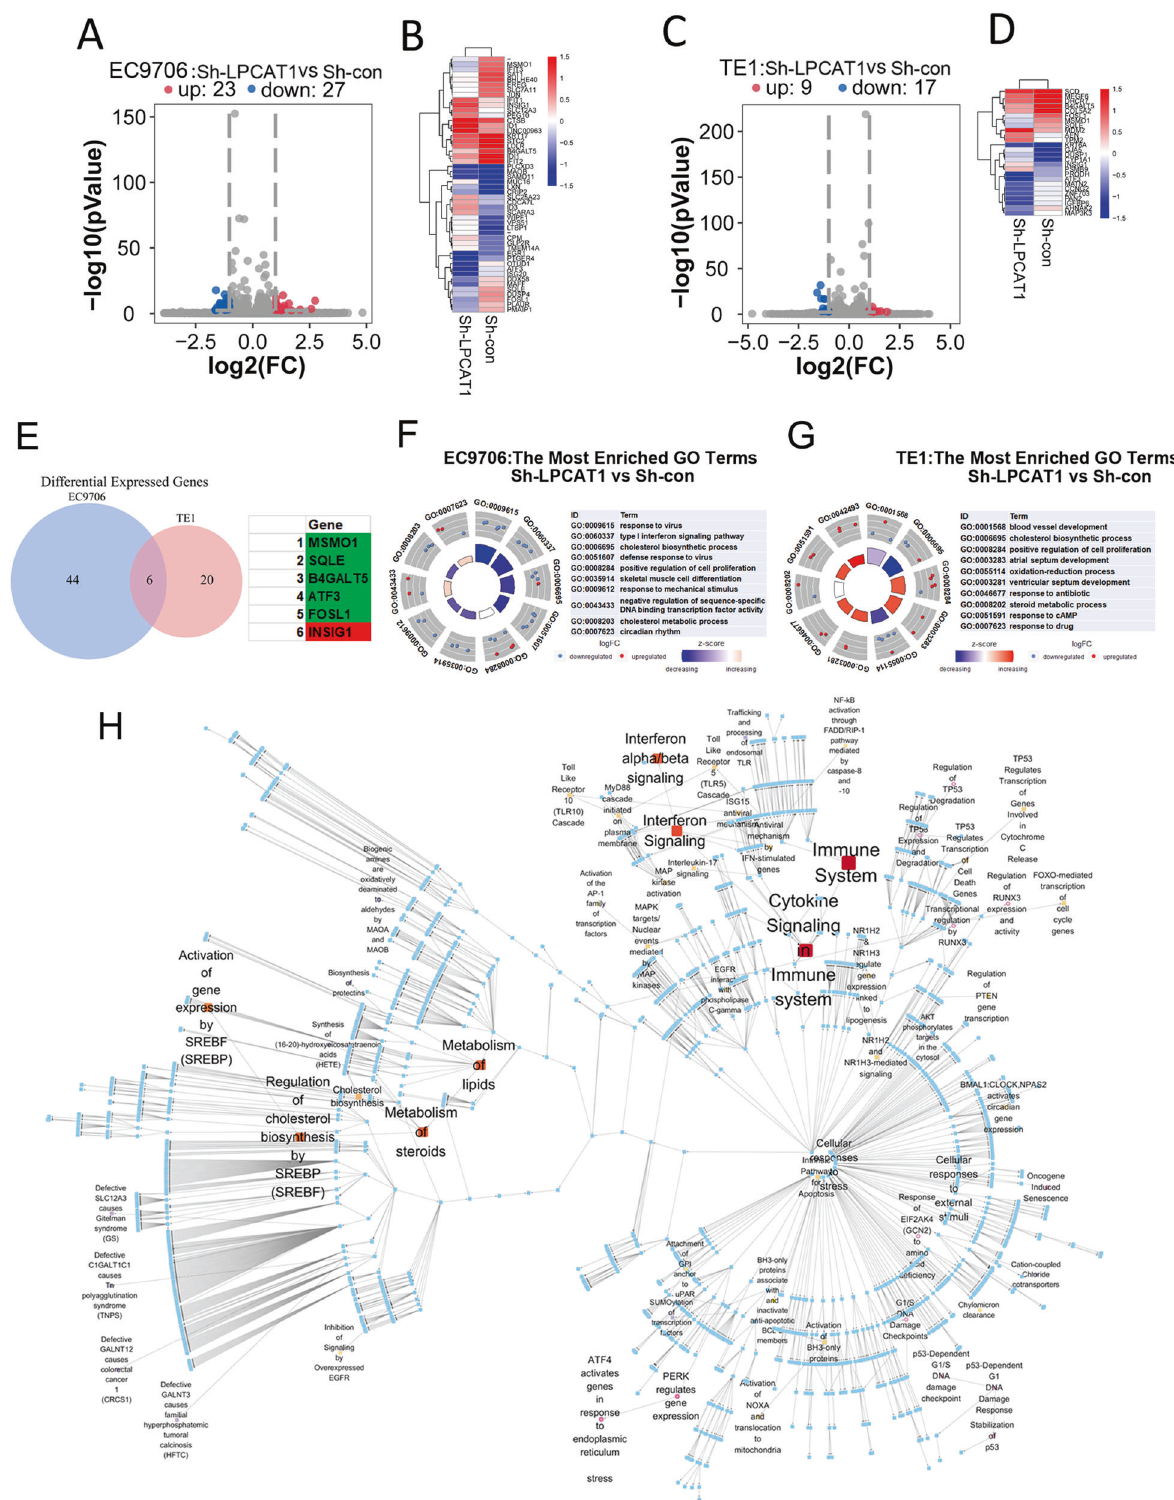
Fig. 4 LPCAT1 promote the expression of cholesterol synthesis signal pathway genes in esophageal squamous cell carcinoma. A Volcano plots showing that, among differentially expressed genes, 23 were upregulated and 27 were downregulated in EC9706 cells after knockdown of LPCAT1. B A cluster heat map was used to show the expression variations of these gene transcripts in EC9706 cells. C Volcano plots illustrating that, among differentially expressed genes, 9 were upregulated and 17 were downregulated in TE1 cells after knockdown of LPCAT1. D A cluster heat map was used to show the expression variations of these gene transcripts in TE1 cells. E Venn analysis of genes with altered expression in EC9706 and TE1 cells after knockdown of LPCAT1. F , G All of the genes altered in EC9706 and TE1 cells were subject to GO analysis. H All genes with altered expression were enriched and analyzed by human gene signaling